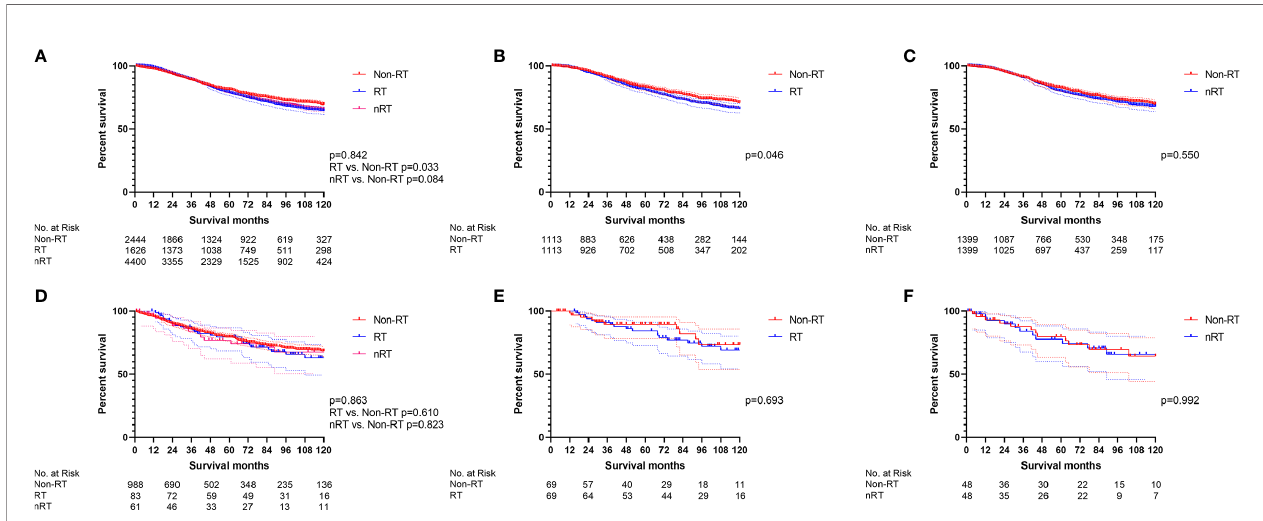
FIGURE 3 | The survival curves were used to demonstrate the effect of radiotherapy in early onset stage II/III RC patients. (A) The total early onset stage II/III RC patients before PSM. (B) RT vs . non-RT in all early onset stage II/III RC patients after PSM. (C) nRT vs . non-RT in all early onset stage II/III RC patients after PSM. (D) The early onset stage II/III RC patients without chemotherapy before PSM. (E) RT vs . non-RT in early onset stage II/III RC patients without chemotherapy after PSM. (F) n RT vs . non-RT in early onset stage II/III RC patients without chemotherapy after PSM. (The results of PSM are summarized in Table S2 ).